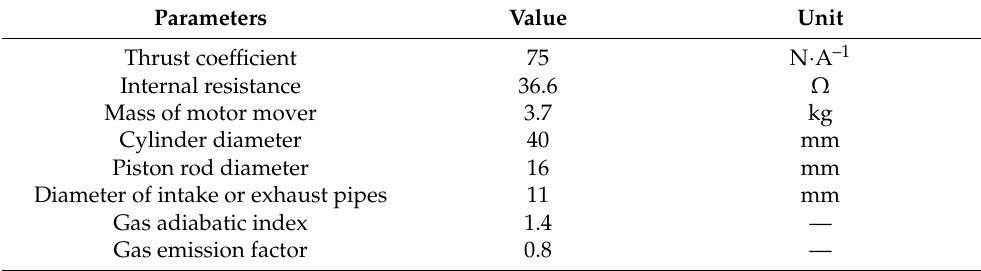
Table 2. Main parameters of FPE–LG model.